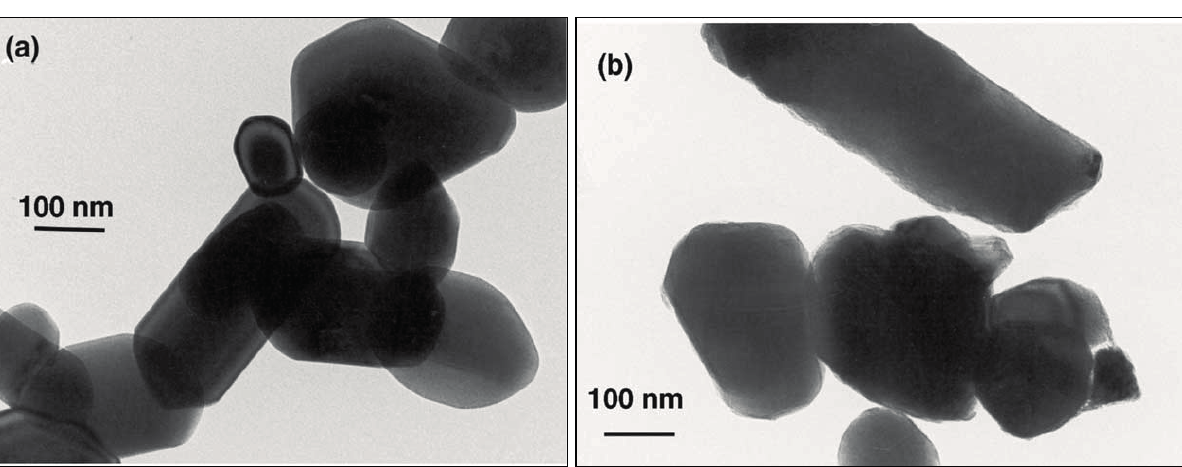
Figure 9. Transmission electron micrographs showing ( a ) the uncoated TiO2 crystals and ( b ) surface treated (coated) TiO2 rutile pigment. The ZrO2/Al2O3 coating, with a thickness of 3–10 nm, shows as a less dense outline to the images (reprinted from J. Mater. Sci. 2002 , 37 , 4901–4909 [47] with